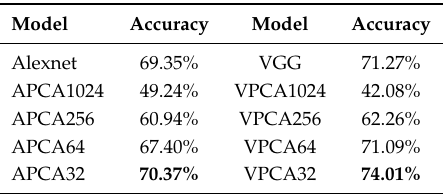
Table 11. Retrieval accuracies of the different dimensional features obtained using the DPCA method according to the P@100